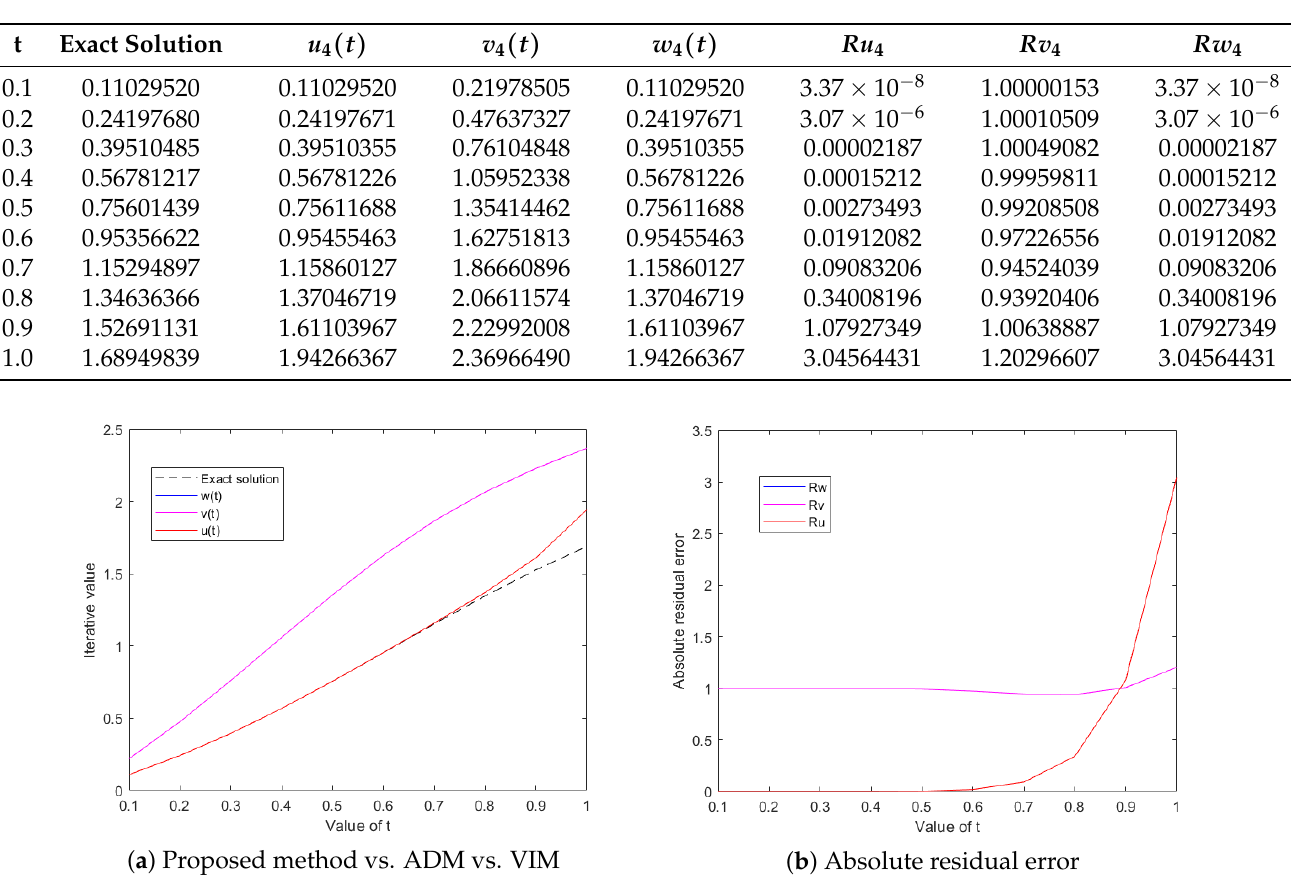
Table 2. Comparison of numerical results for Example 2.